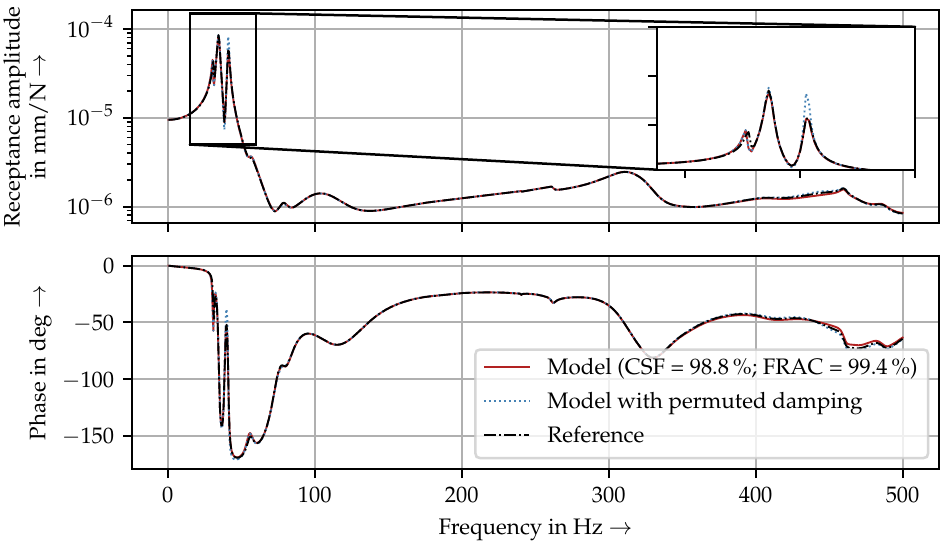
Figure 7. Identified and reference FRFs in the x -direction from force to displacement at the WPT at the validation position z 1 = 294mm for the case “ideal model vs. simulated data”; for better readability, − the highlighted section has a linear amplitude scale in contrast to the main plot. Additionally, a model FRF is shown where the identified damping deviations were permuted randomly, emphasizing the need for properly identified damping